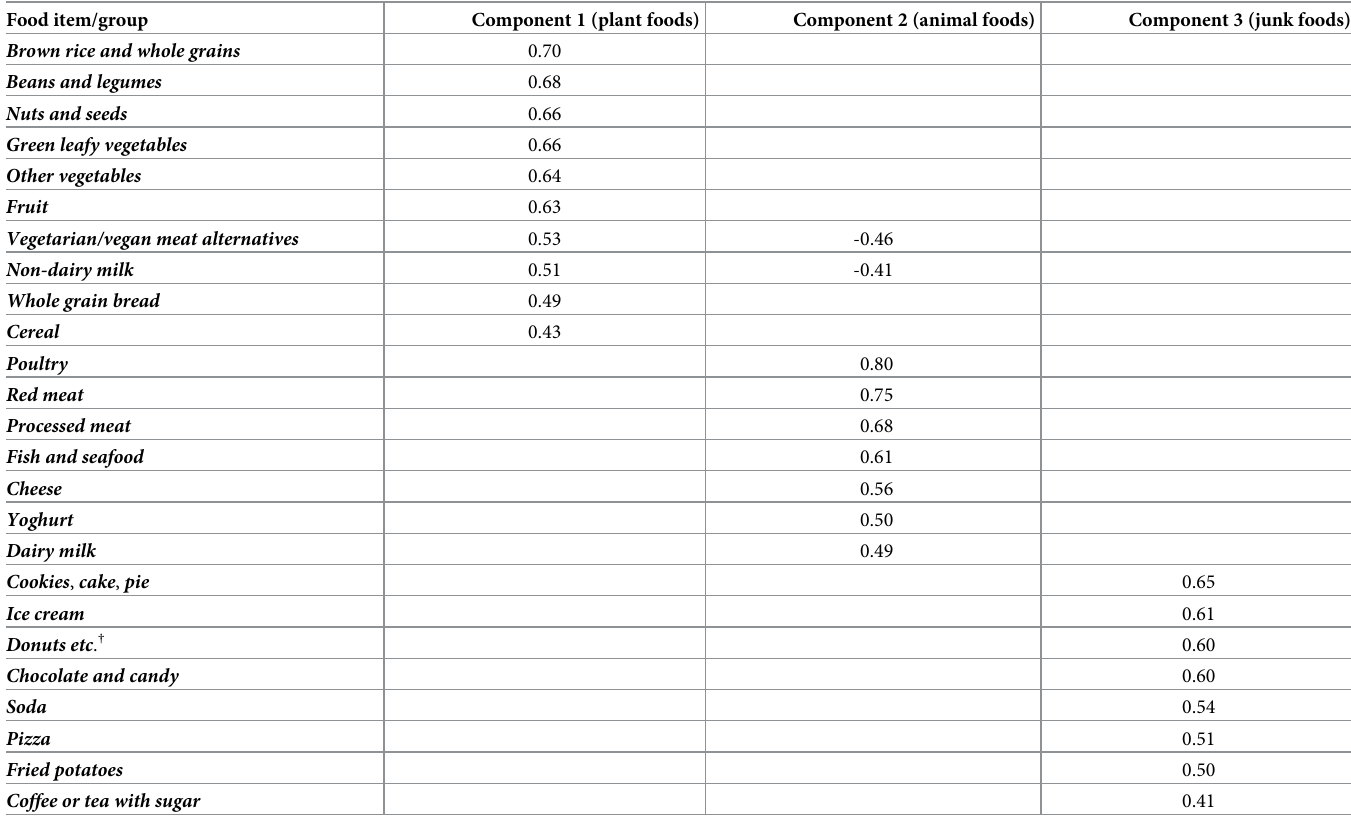
Table 2. Principal component analysis of dietary components and component loadings for dietary patterns after varimax rotation. Food